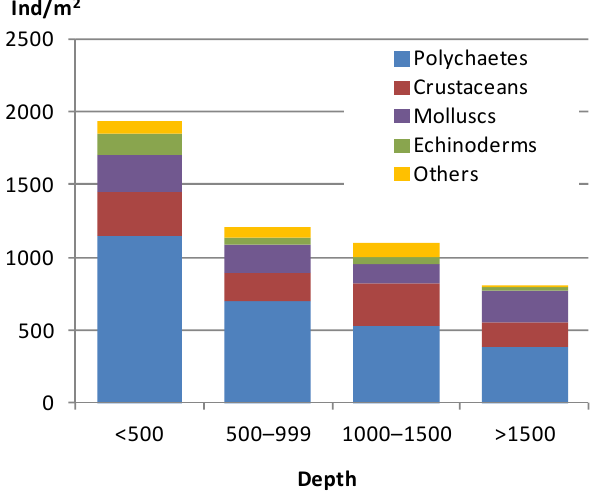
Figure 2. Abundance indices (indv/m 2 ) of the major macrofauna taxa on the ACS according to depth (m).